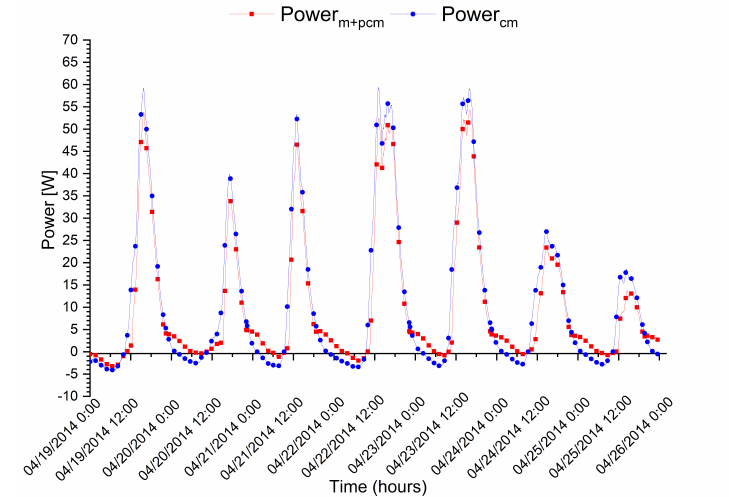
Figure 16. Comparison of the power released by the solar wall. Power m+pcm and Power cm denote respectively the evolution in the numerical results of power released from the solar wall integrating a storage wall containing PCM and that integrating a storage wall made from cement